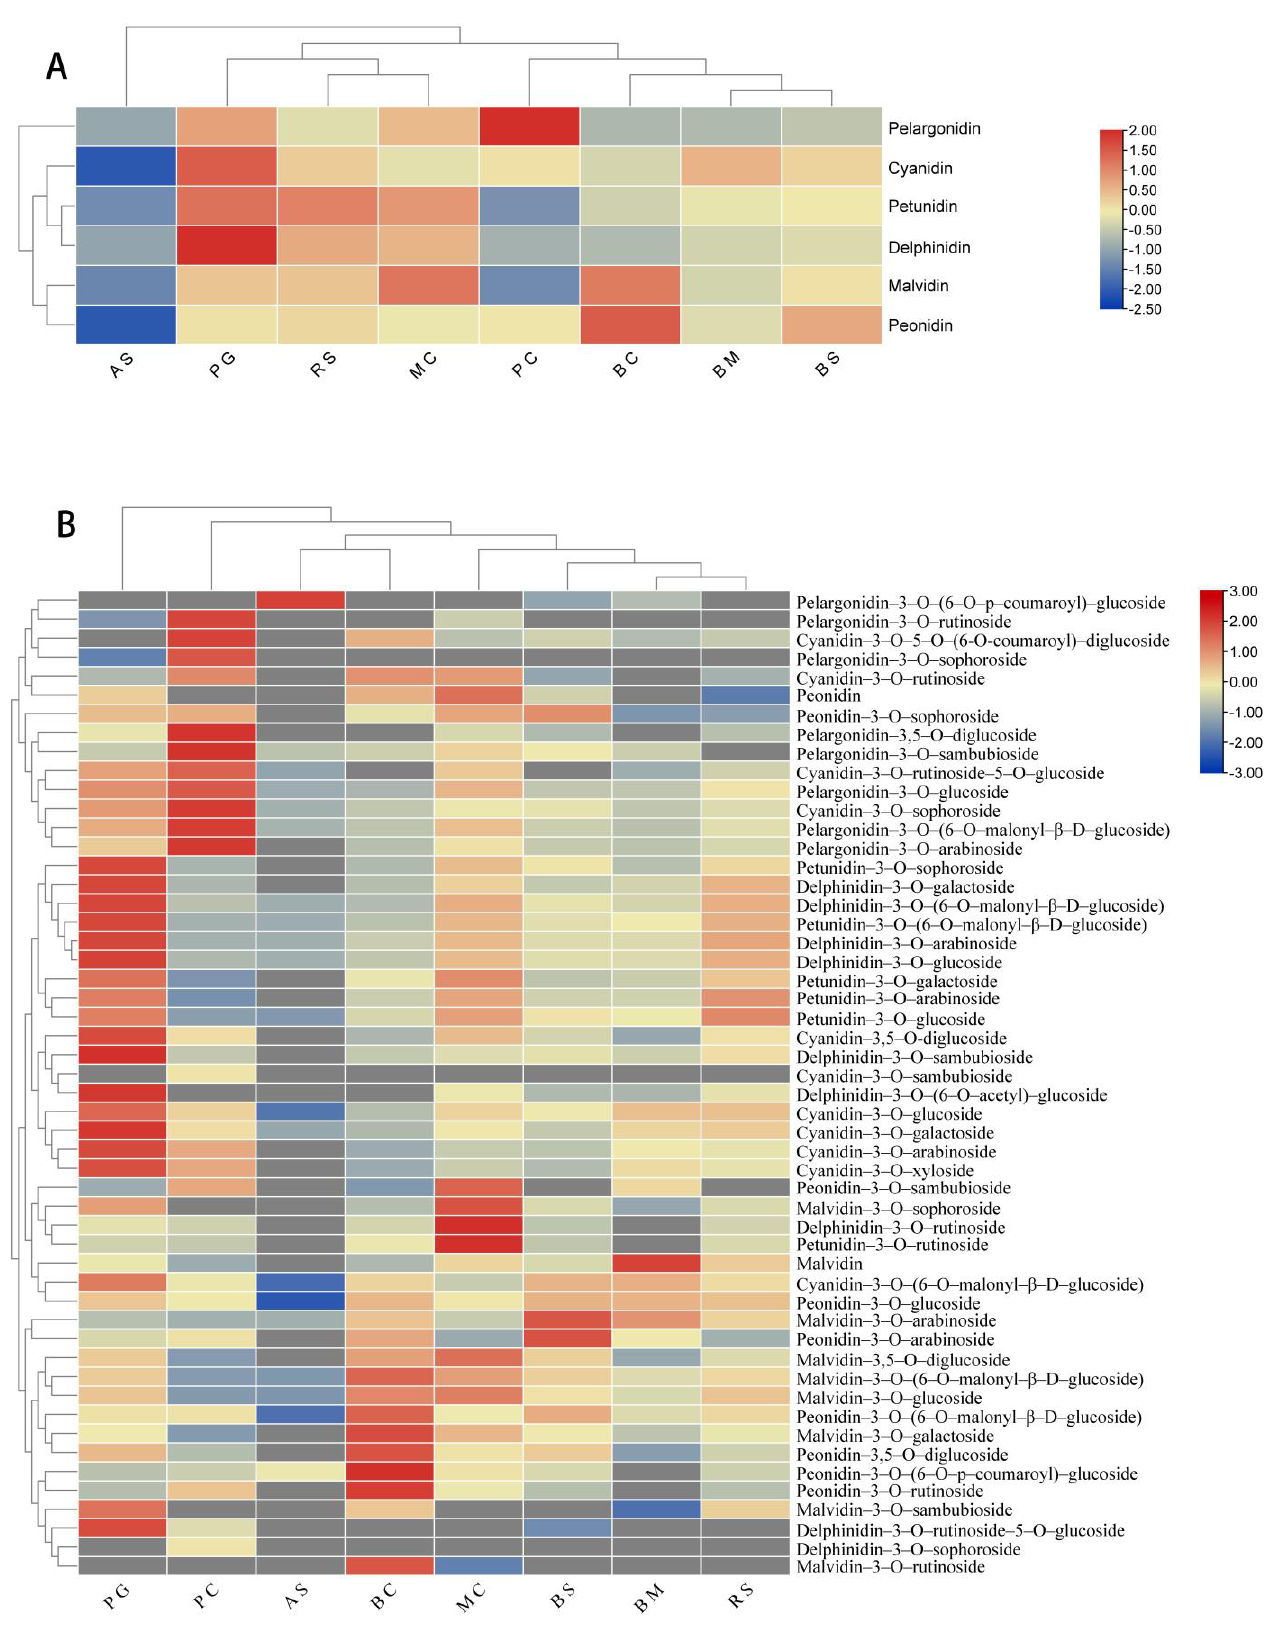
Figure 7. Heat map of relative anthocyanin contents of different Hibiscus syriacus ( A ), clustering heat map of relative anthocyanin component contents of different Hibiscus syriacus ( B ).